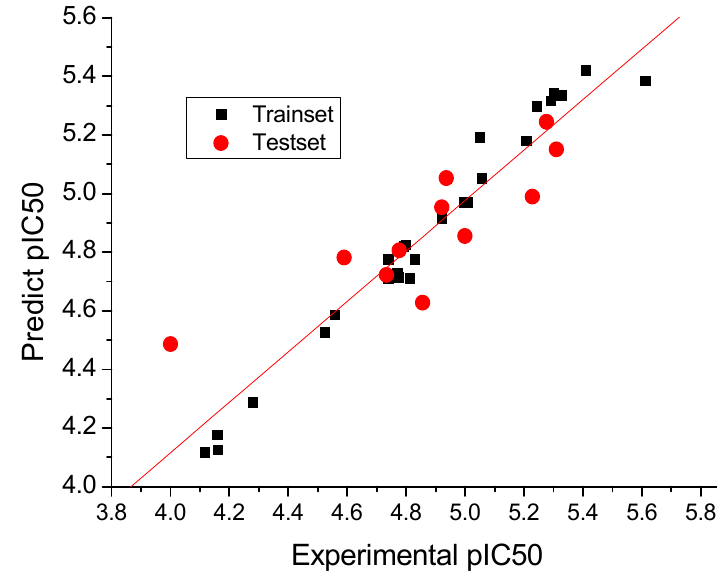
Figure 3. Graph of the experimental versus predicted pIC set using topomer